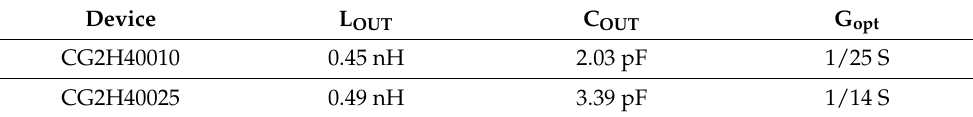
Table 2. Parasitic estimations for the CG2H40010 and CG2H40025 GaN HEMT devices. Device